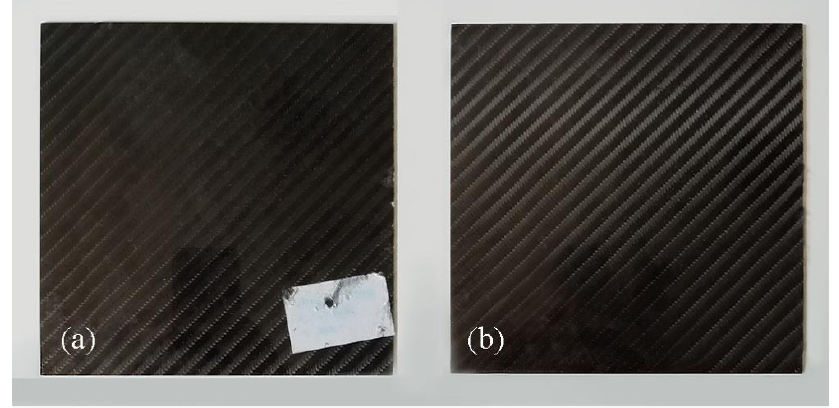
Figure 3. ( a ) Autoclave and ( b ) VBO CFRE plates.